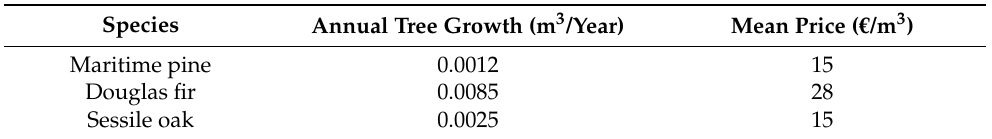
Table 3. Annual tree growth and mean price for the lowest diameter class for the three species (maritime pine ( Pinus pinaster Ait.), Douglas fir ( Pseudotsuga menziessi Mirb.), and sessile oak ( Quercus petraea